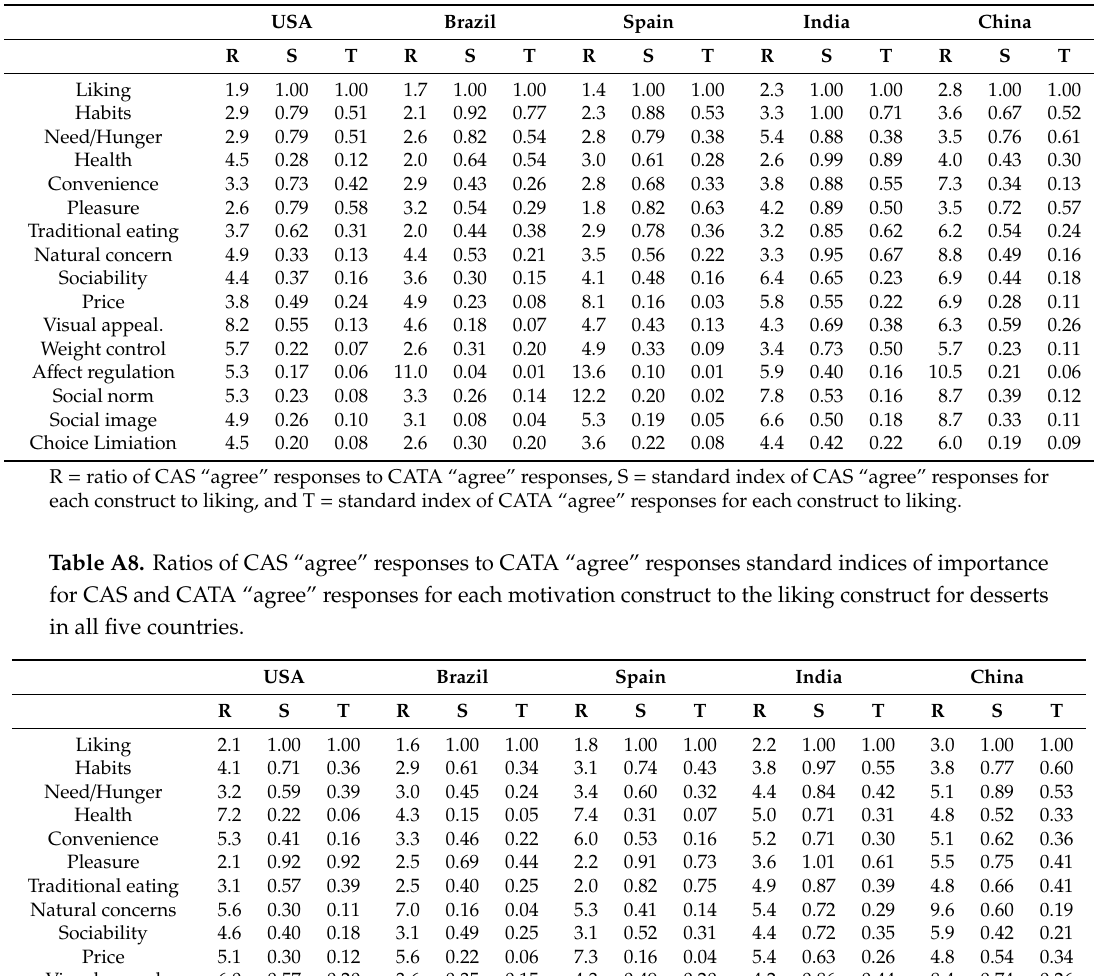
Table A7. Ratios of CAS “agree” responses to CATA “agree” responses and standard indices of importance for CAS and CATA “agree” responses for each motivation construct to the liking construct for protein-rich foods in all five